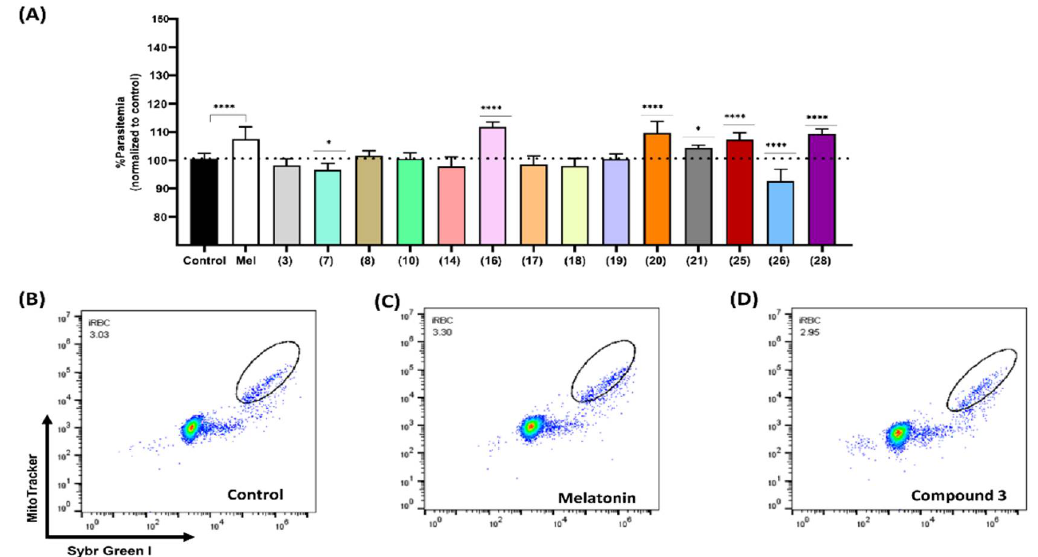
Figure 3. Effects of 2-sulfenyl indoles on the parasitemia of P. falciparum after 48 h of incubation with 500 nM compounds 3 , 7 , 8 , 10 , 14 , 16 , 17 , 18 , 19 , 20 , 21 , 25 , 26 , and 28 ( A ). Dot plots showing SG-I/MT-Red-labeled parasites detected by flow cytometry after 48 h of treatment with DMSO ( B ), 100 nM melatonin ( C ), and 500 nM compound 3 ( D ). Data are presented as the percentage of parasitemia normalized to that of the control group treated with solvent (DMSO). Experiments were performed 3 independent times in triplicate. The error bars represent the SD. * indicates a significant difference from the control group. Statistical significance was calculated using one-way ANOVA followed by Dunnett’s test: * p ≤ 0.05, **** p ≤ 0.0001.